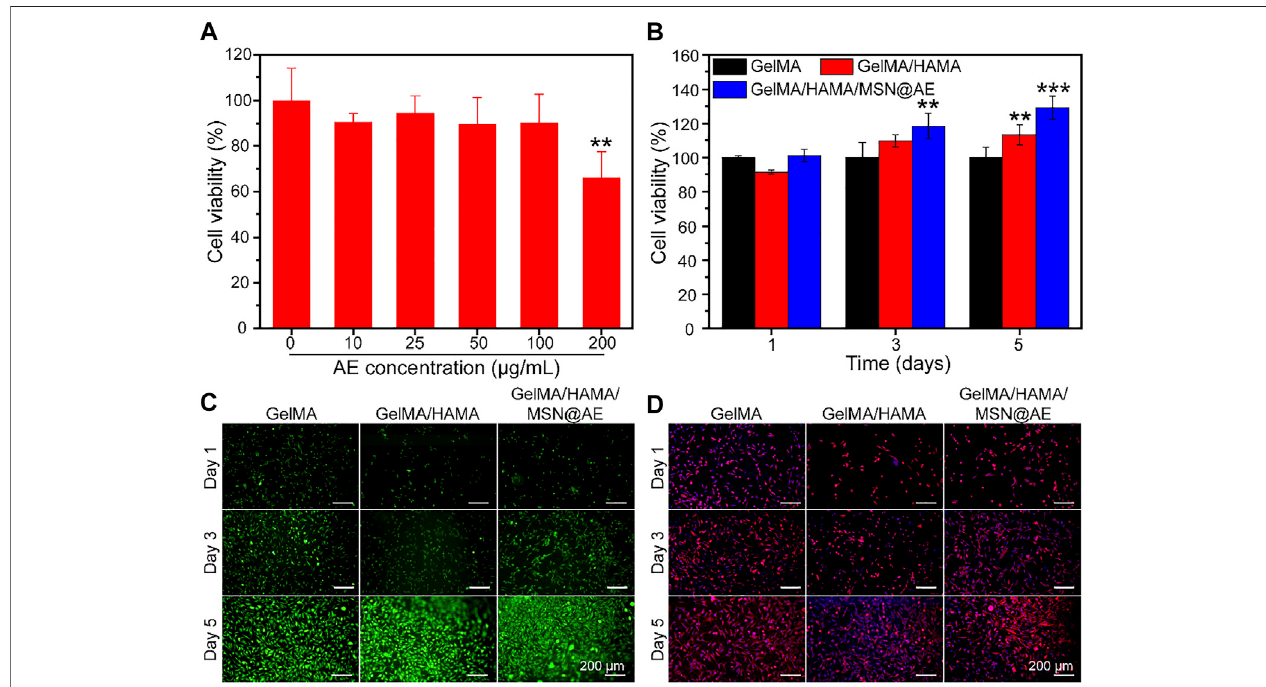
FIGURE4|(A) CellviabilityofMSN@AEwithdifferentAEconcentrations. (B) CellviabilityofL929cellsgrownonGelMA,GelMA/HAMA,andGelMA/HAMA/MSN@ AE hydrogels at days 1, 3, and 5. (C) Live/dead staining images of L929 cells grown on the hydrogels. (D) Cytoskeletal staining images of L929 cells grown on the hydrogels. (* p < 0.05, ** p < 0.01, and *** p <